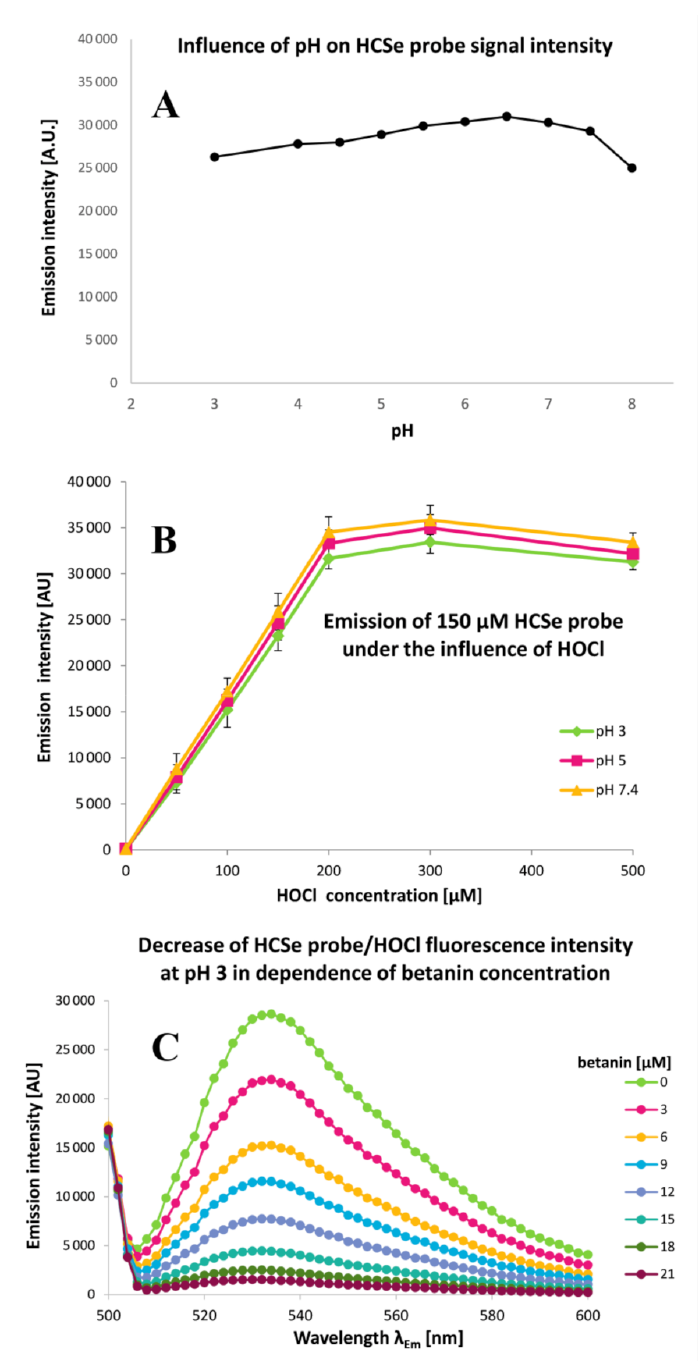
Figure 6. Dependence of the 150 µ M HCSe fluorescent probe emission intensity ( A ) on the pH of buffers added to aqueous/acetonitrile solutions of 150 µ M NaOCl at 25 ◦ C. Linearity of the changes in fluorescence intensity of the HCSe probe ( B ) under the influence of increasing concentration of HOCl at pH 3, 5, and 7.4 (measured in triplicate) is presented at λ Ex 480 nm and at λ Em 536 nm. Decrease in the HCSe probe emission intensity ( C ) due to increasing concentration of betanin after 5 min of pigment incubation with 150 µ M HOCl at pH 7.4 is shown in the emission